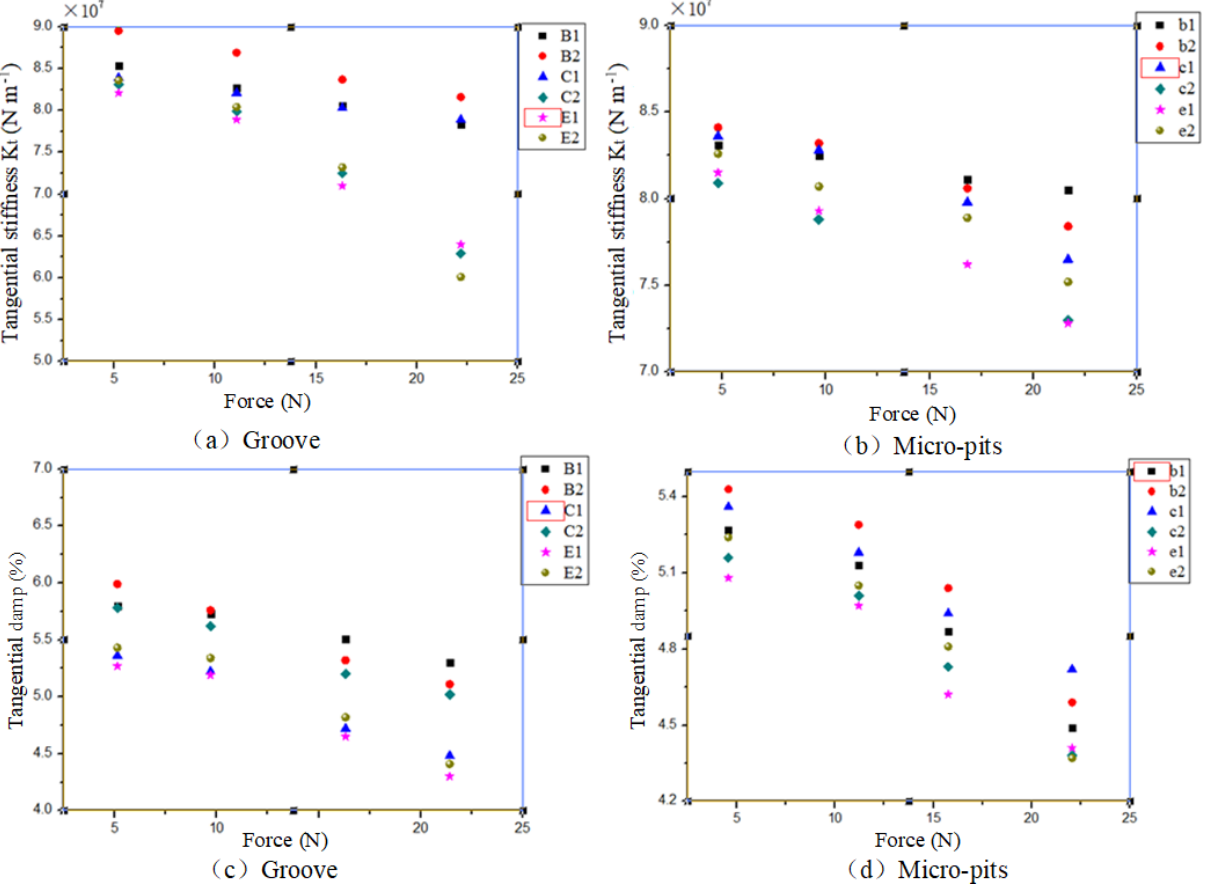
Figure 21. (a, b) The impact of exciting force on the tangential stiffness (groove and micro-pits). (c, d) The impact of exciting force on the tangential damp (groove and